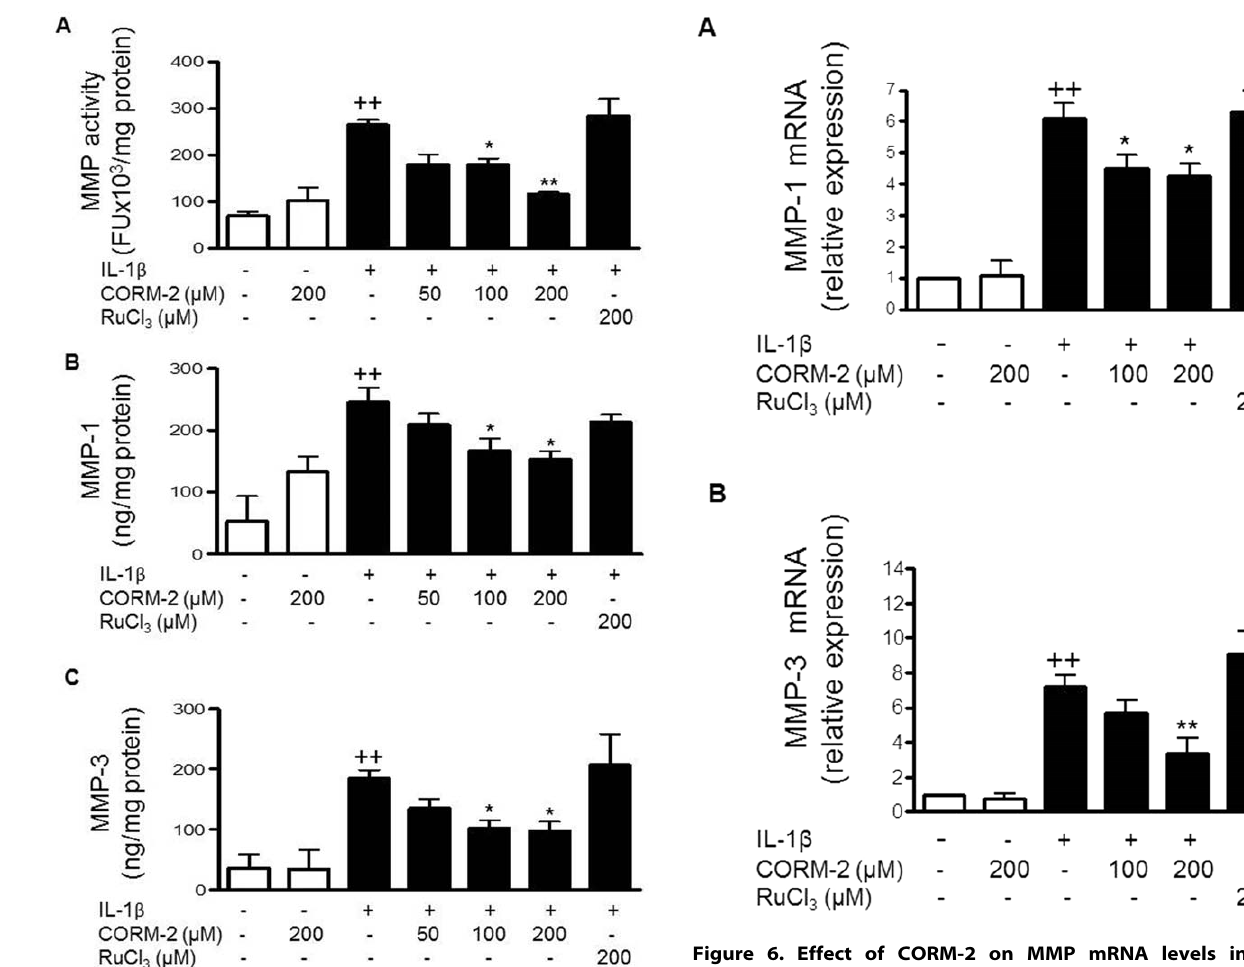
Figure 6. Effect of CORM-2 on MMP mRNA levels in OA synoviocytes. (A) MMP-1, (B) MMP-3 mRNA levels. Cells were stimulated with IL-1 b (10 ng/ml) for 16 h in the presence or absence of CORM-2 (100, 200 m M) or RuCl 3 (200 m M). mRNA expression was measured by real-time PCR. Data are expressed as mean 6 S.E.M. Duplicate samples from 6 patients were used. ++ P , 0.01 with respect to nonstimulated cells. * P , 0.05, ** P , 0.01 with respect to IL-1 b .